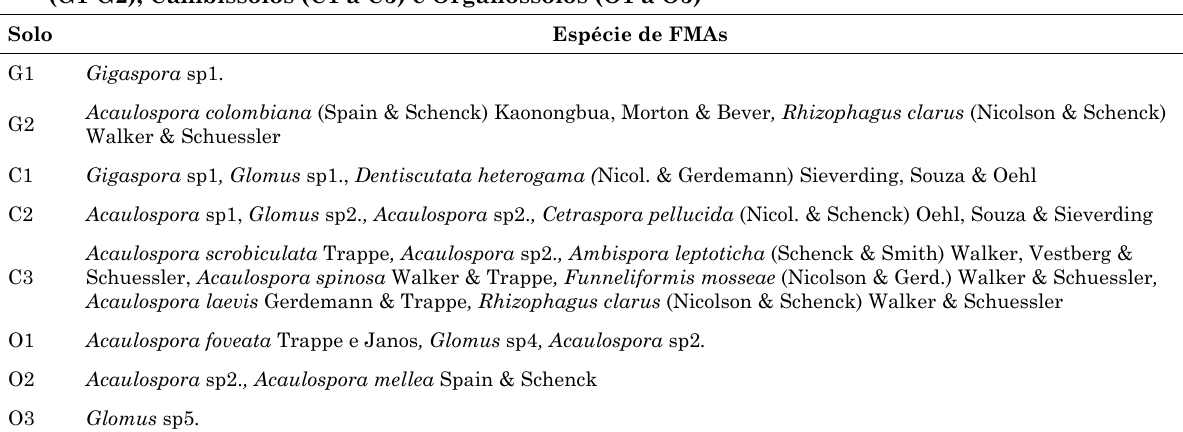
Quadro 2. Espécies de fungos micorrízicos arbusculares (FMAs) encontradas em áreas de Gleissolos (G1-G2), Cambissolos (C1 a C3) e Organossolos (O1 a O3) Espécie de FMAs